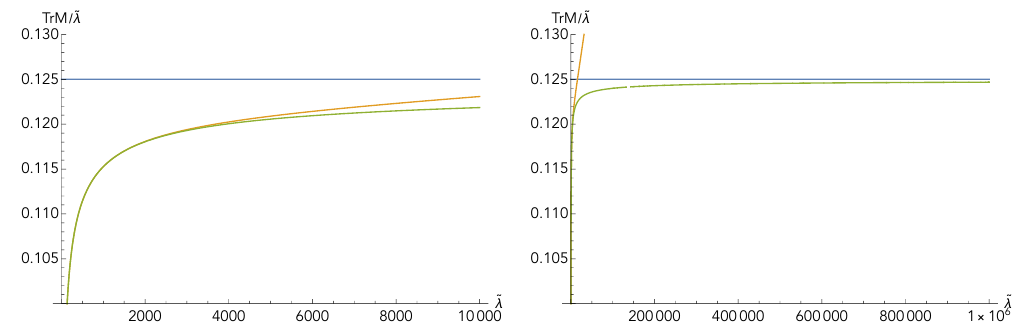
Figure 3 . Extrapolations of tr M (˜ λ ) / ˜ λ compared to the analytic value 1 / 8 (blue line). The left and right plot differ only in the range of ˜ λ values, 10 4 on the left and 10 6 on the right. The orange line is diagonal Padé of order 75, applied to the first 150 terms in the weak coupling expansion (6.6). The green line is the Padé-conformal extrapolation based on the transformation